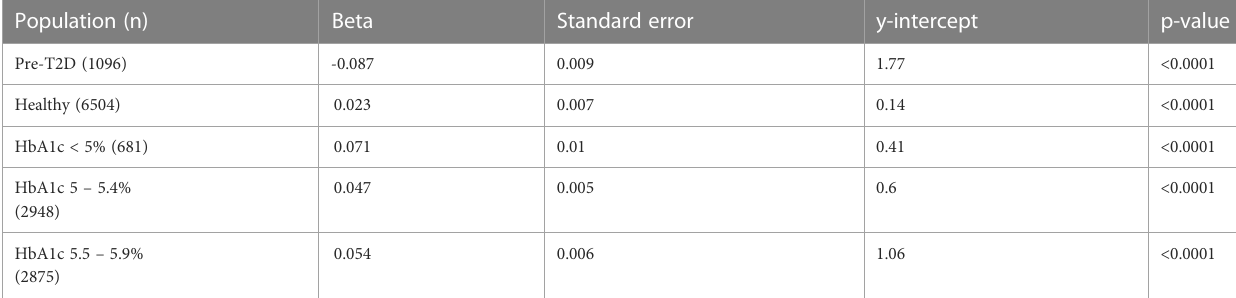
TABLE 5 Linear regression for Triglyceride Glucose Index (exposure) on glycation gap*